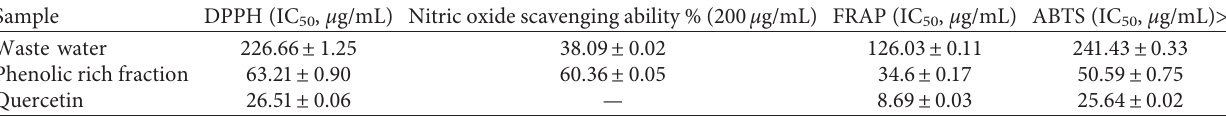
Table 2: Antioxidant activities of the extract of waste water before and after (phenolic rich fraction) loading on column.